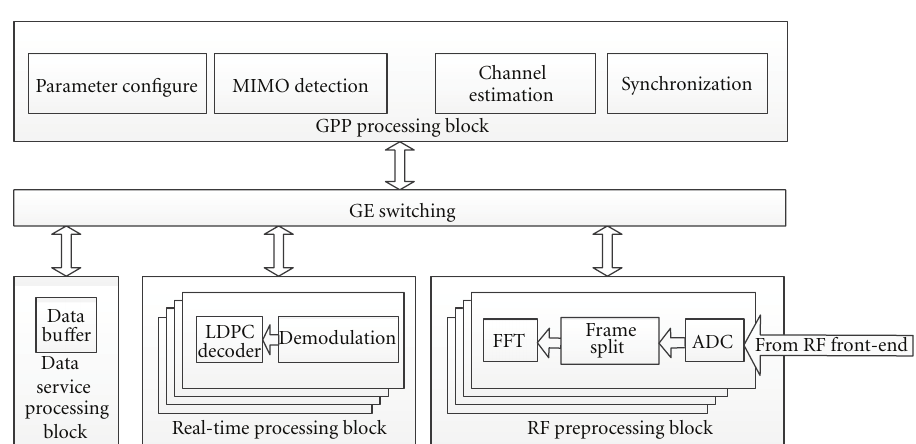
Figure 8: Transmitter structure.